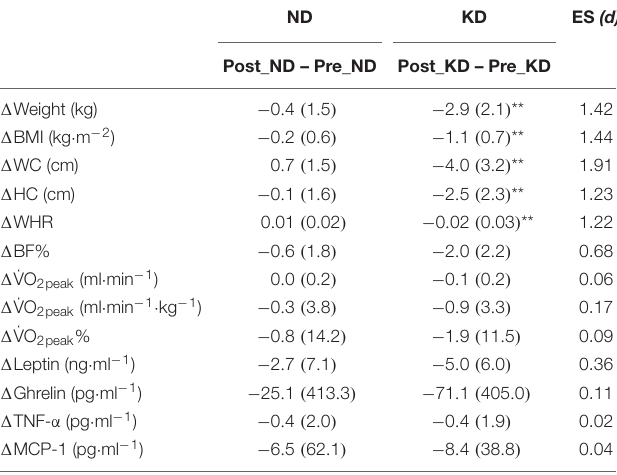
TABLE 2 | Changes in outcome variables after ND and KD. ND KD